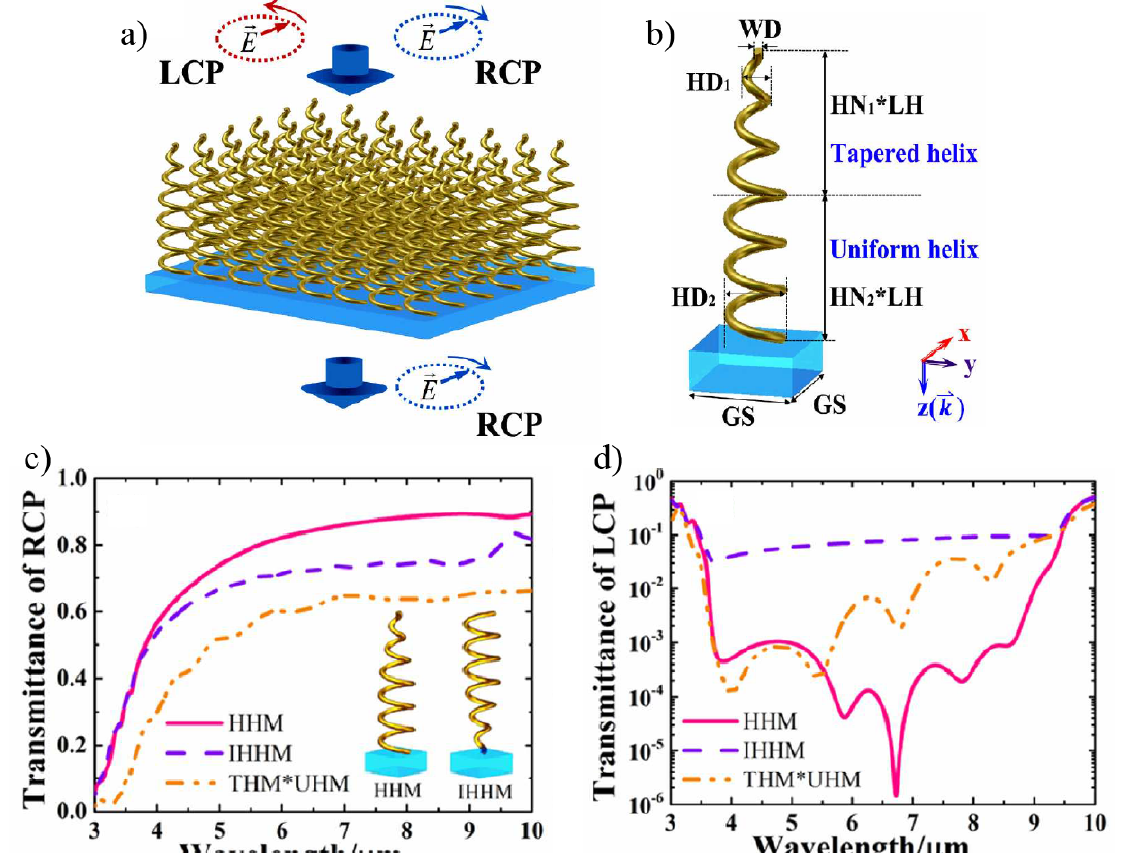
Figure 9. ( a ). Illustration of hybrid nanohelices array on a substrate and the polarization filter potential. ( b ) A single hybrid nanohelix, made by a uniform (UHM) and a tapered (THM) helices, with their own diameter (HD 1 and HD 2 ). Transmittance spectra of RCP ( c ) and LCP ( d ) of hybrid (HHM), inverted hybrid (IHHM) and the junction of THM and UHM helices. Reproduced with permission from ref. [93]. Copyright 2016 American Chemical